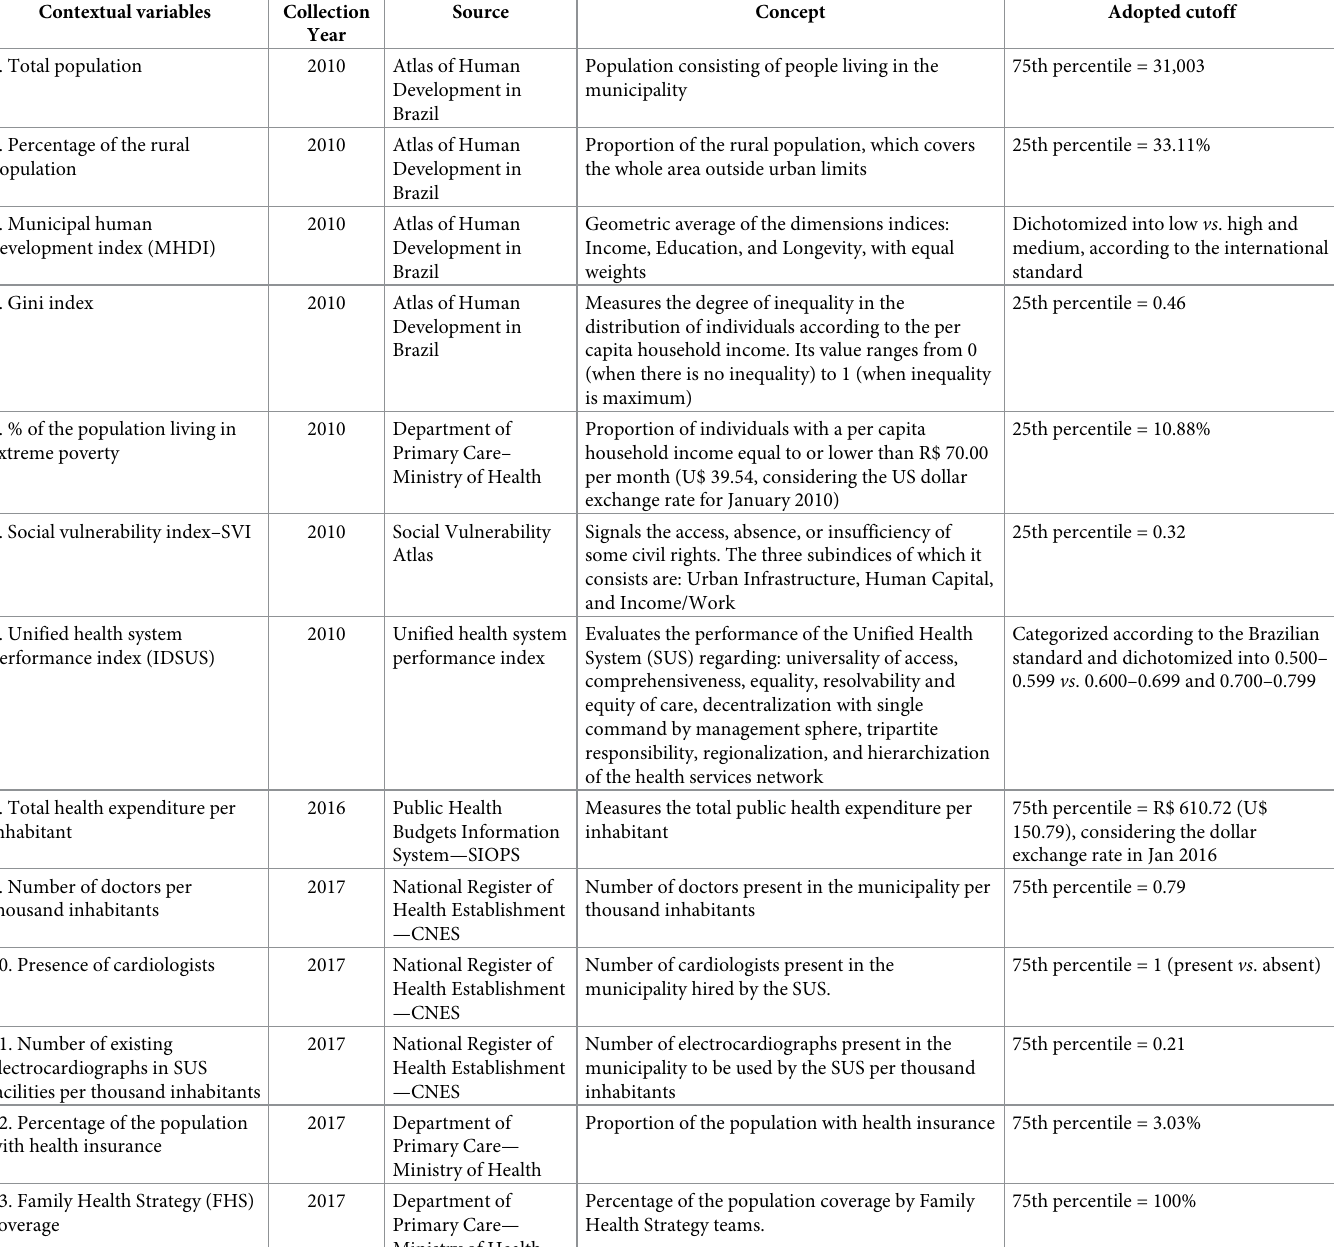
Table 1. Contextual variables collected in publicly accessible institutional platforms and information systems, according to the year, source, concept, and cutoff point adopted in the